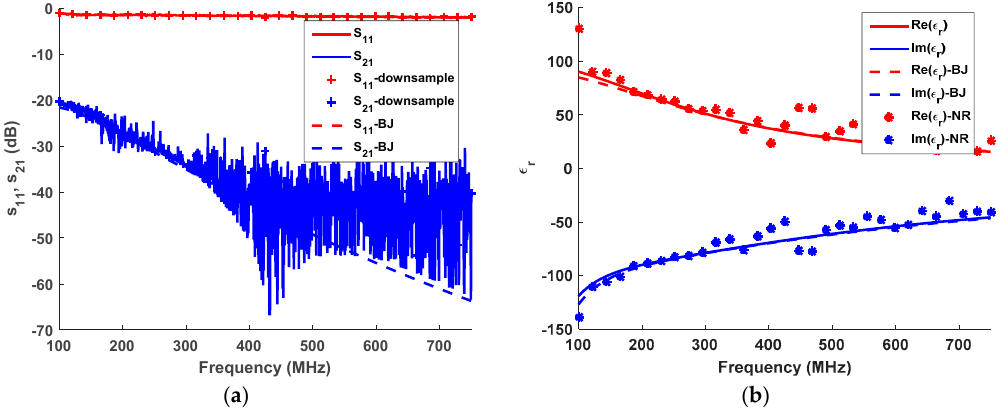
Figure 10. Real and imaginary parts of the dielectric permittivity estimated with NRW and the iterative method employing the Debye dispersion model with µ r = 1 for the case of a dielectric sample with thickness equal to 10 cm ( a ) and 15 cm ( b ). In this case, the processed data are not affected by noise.